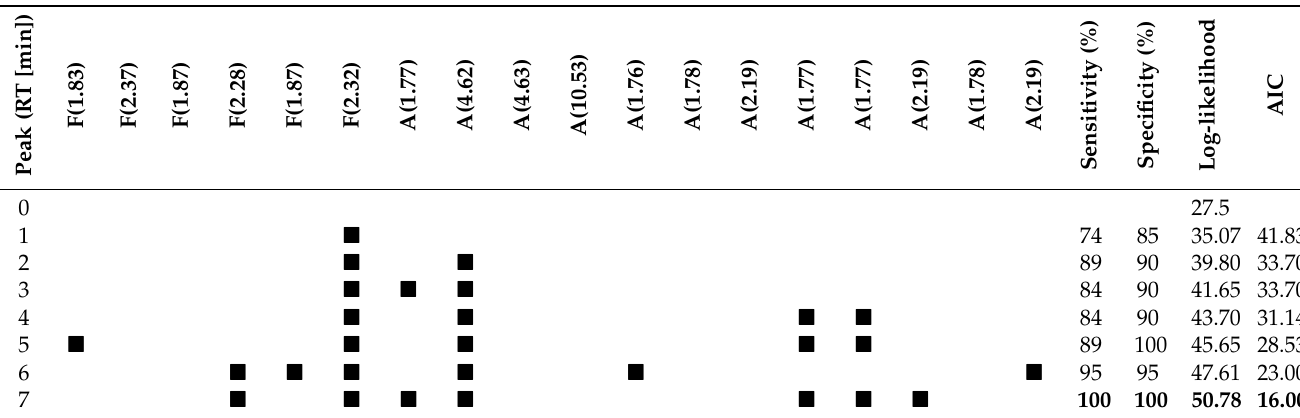
Table 6. Results of models obtained from logistic regression.